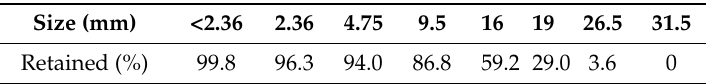
Table 2. Particle size distribution of coarse steel